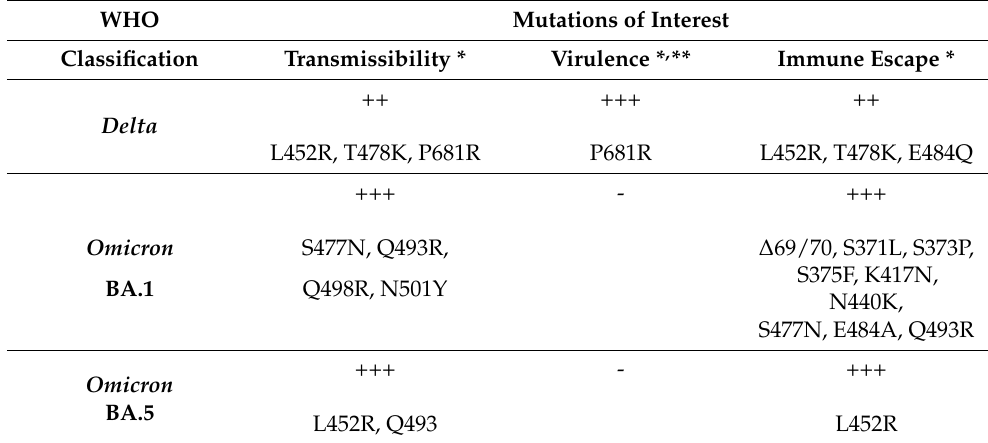
S375F, K417N, N440K, S477N, E484A, Q493R